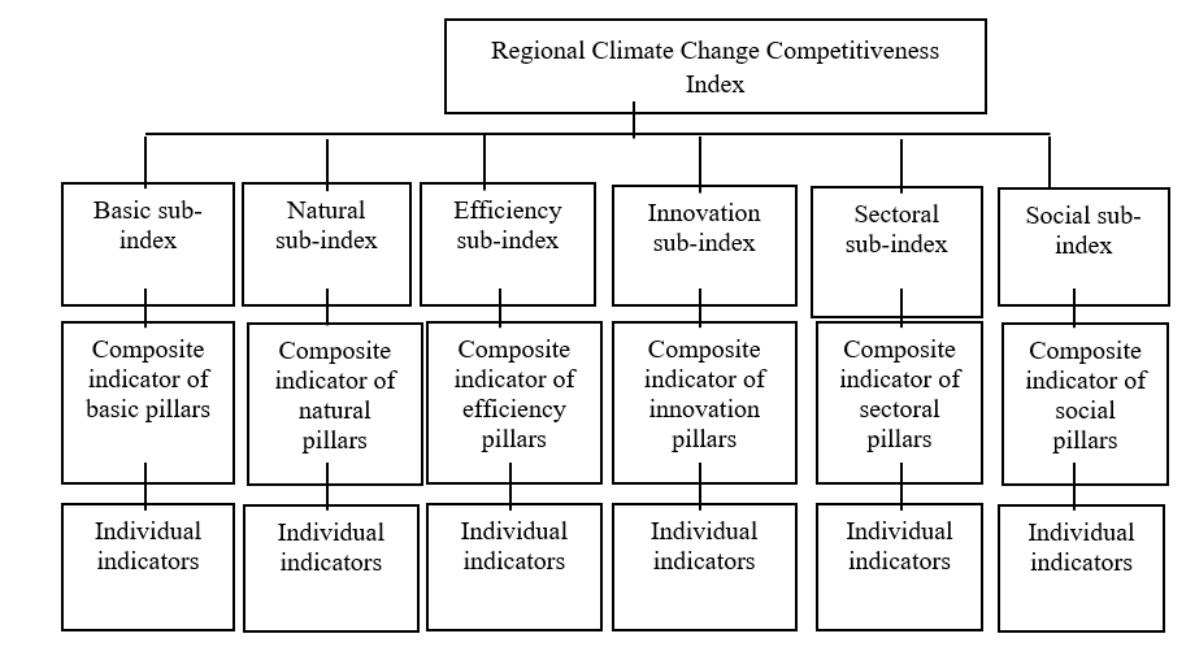
Figure 2. Synoptic view of the RCCCI.